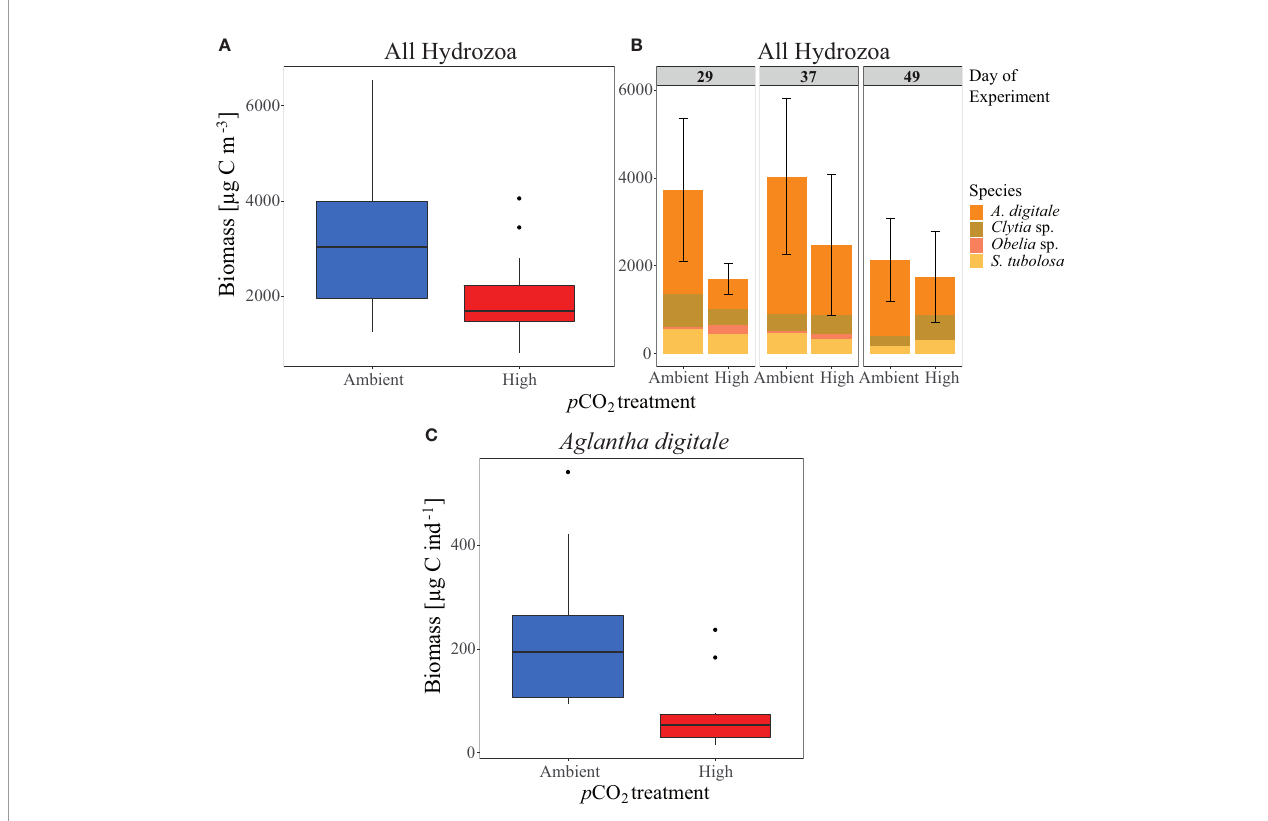
FIGURE 6 | Hydrozoa biomass [μg C m -3 ] development per p CO 2 treatment over phase IV of the experiment as (A) combined Hydrozoa mean biomass of the four major species, and (B) biomass contributions of the single species (see given legend) to the overall Hydrozoa biomass per day. Error bars represent the standard deviation of the sum of all listed species, see also Table 1 . (C) Mean biomass per p CO 2 treatment, per individual [μg C ind -1 ] of the dominant species Aglantha digitale . All boxplots display the mean and the 95% con fi dence interval of the given